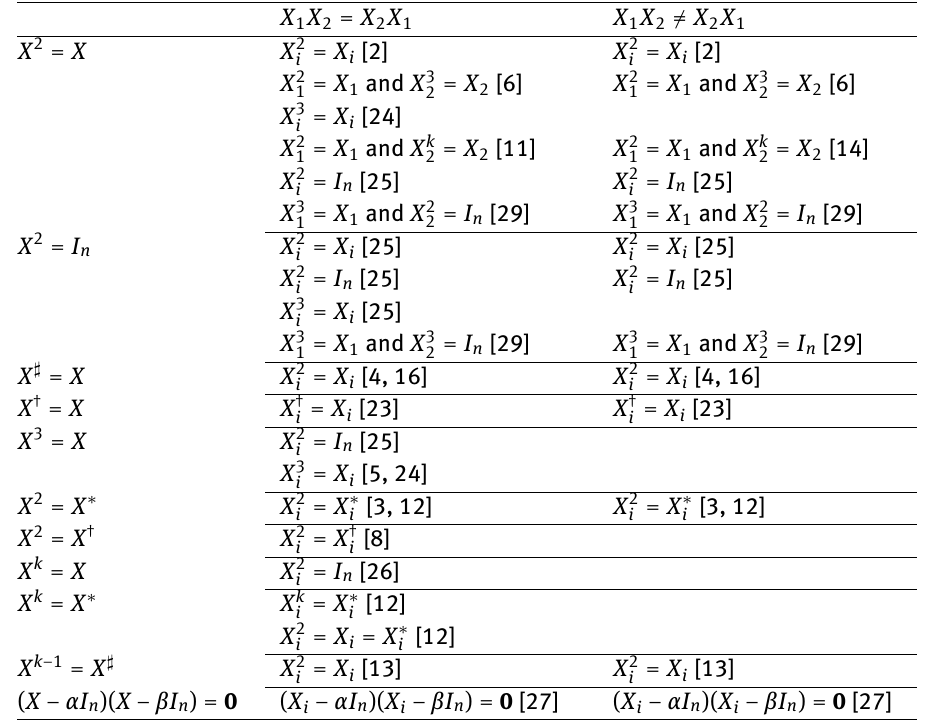
Table 1: Summary of the results in which the linear combinations of the form (1) are